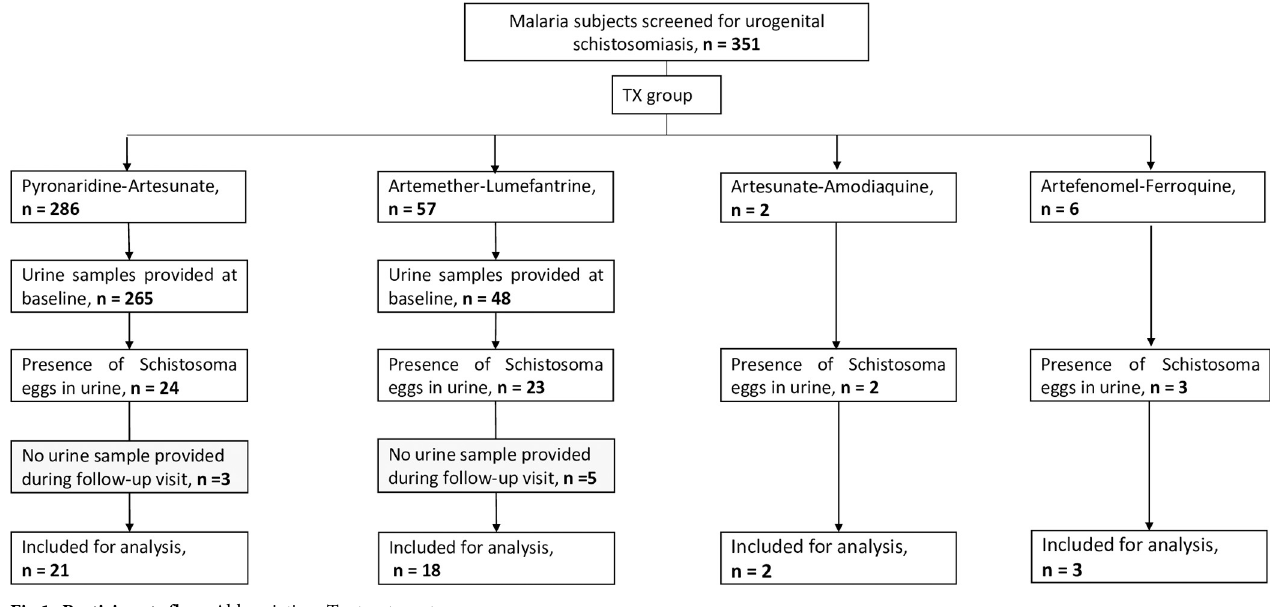
Fig 1. Participants flow. Abbreviation: Tx: treatment.